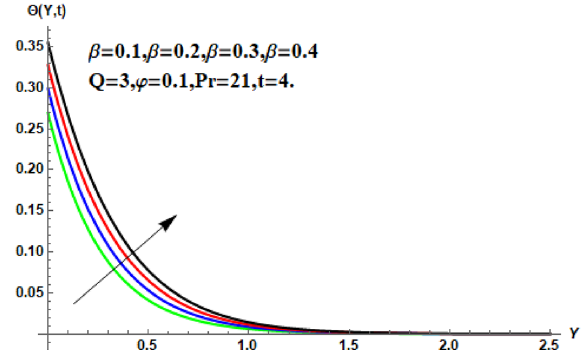
Figure 2. Temperature profile for different values of β .